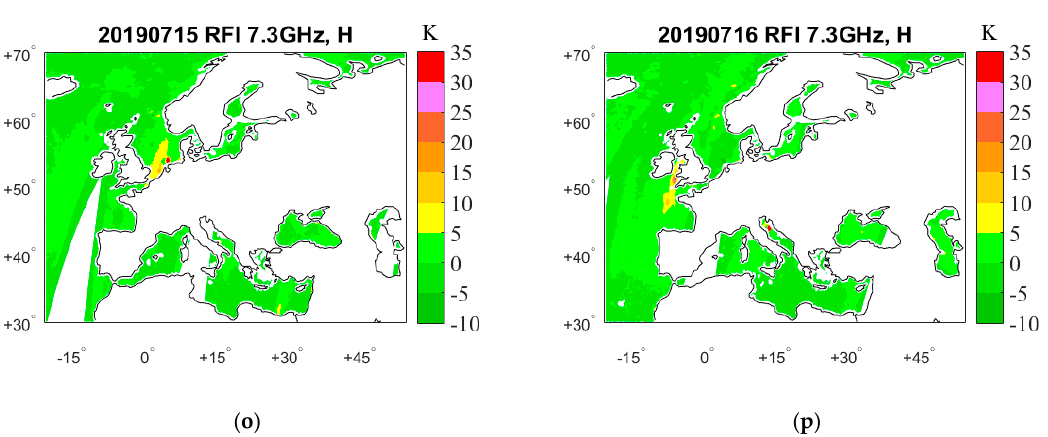
Figure 2. Spatial distribution of 7.3 GHz-H RFI, using GRDM over European waters during the period 1–16 July 2019. ( a ) 1 July; ( b ) 2 July; ( c ) 3 July; ( d ) 4 July; ( e ) 5 July; ( f ) 6 July; ( g ) 7 July; ( h ) 8